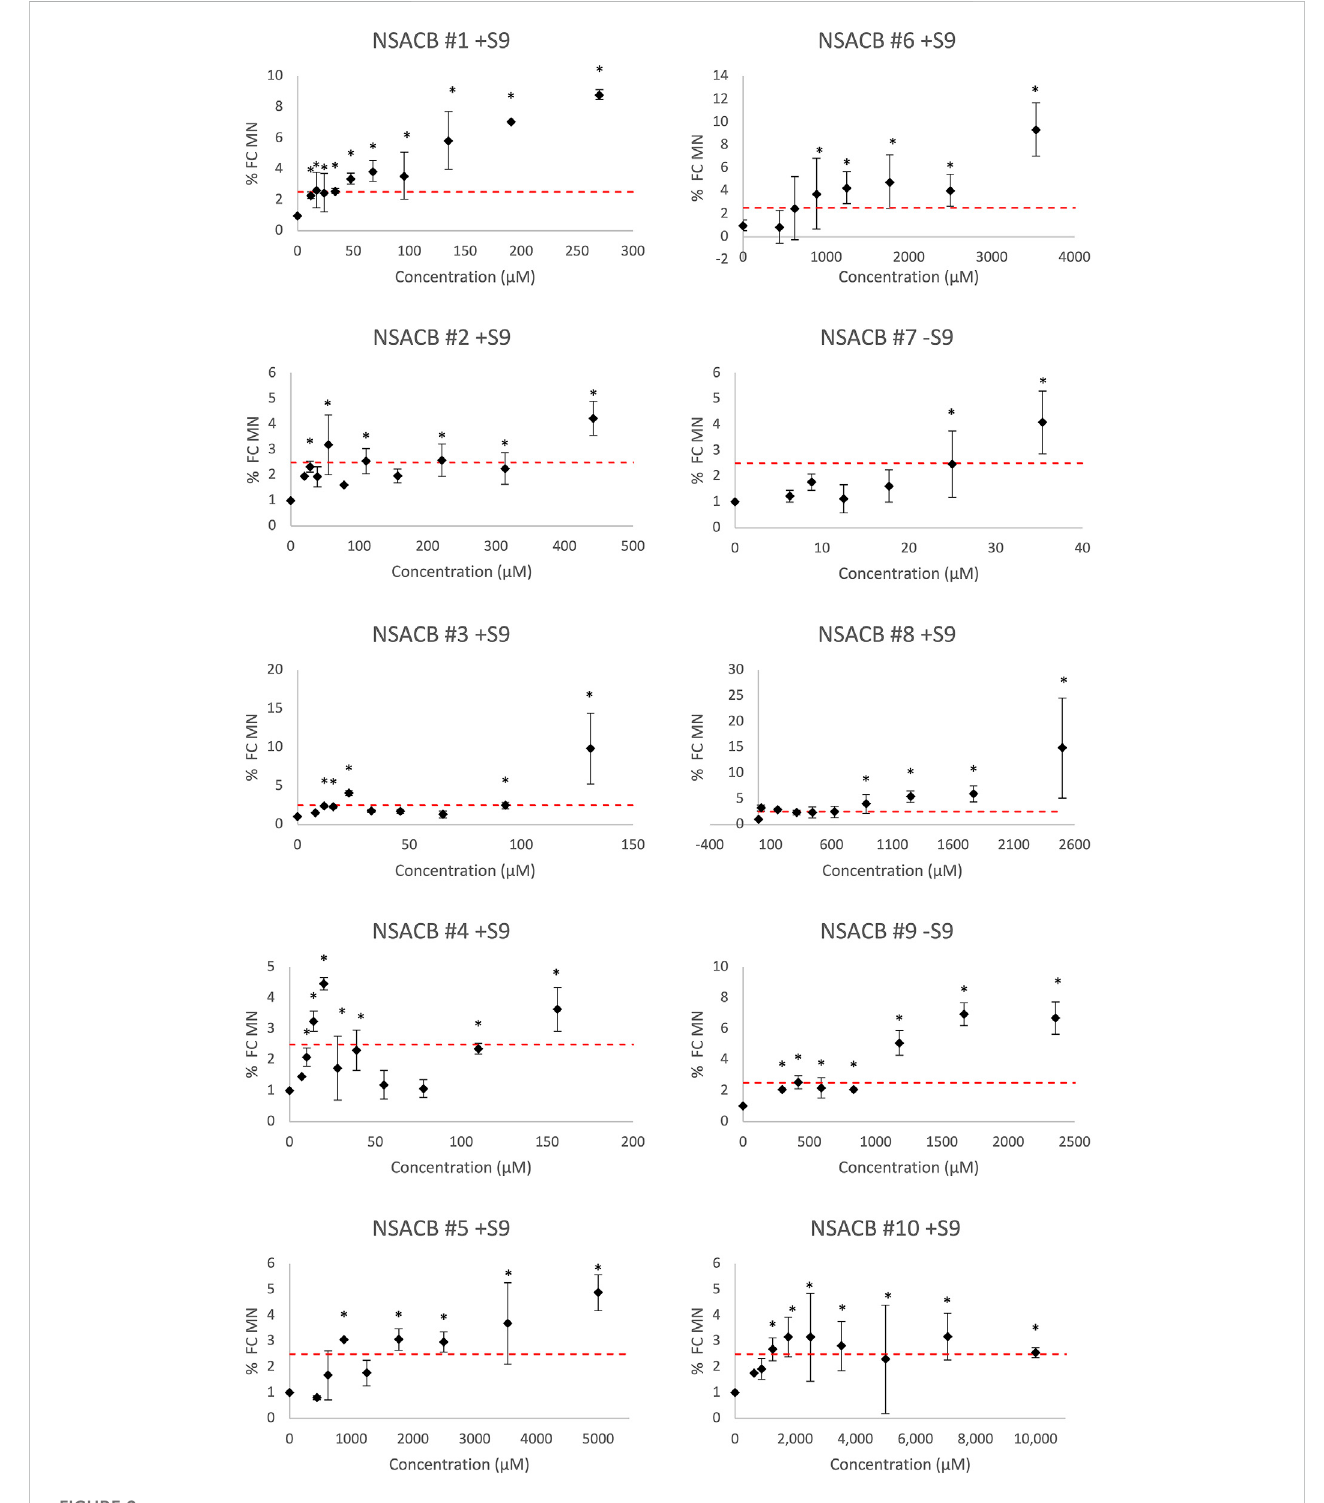
FIGURE 2 Invitro MicroFlow ® assayresultsfortenNSACBdata-poorsubstances(#1 – 10).Fold-changein%micronucleus(%FCMN)comparedtovehiclecontrolis depicted by black diamonds. The dashed red line shows the threshold (i.e., 2.5-fold increase in %MN) required to yield a positive classi fi cation. Statistically signi fi cant ( p < 0.05) increases in %MN in comparison with the concurrent vehicle control are designated by an asterisk (*). Cytotoxic concentrations ( < 40% viability) were removed from the analysis. Error bars denote standard deviation from mean. N = 2. For comparison, the S9 condition presented for each compound is as denoted in Figure 1. Additional results can be found in Supplementary Figure